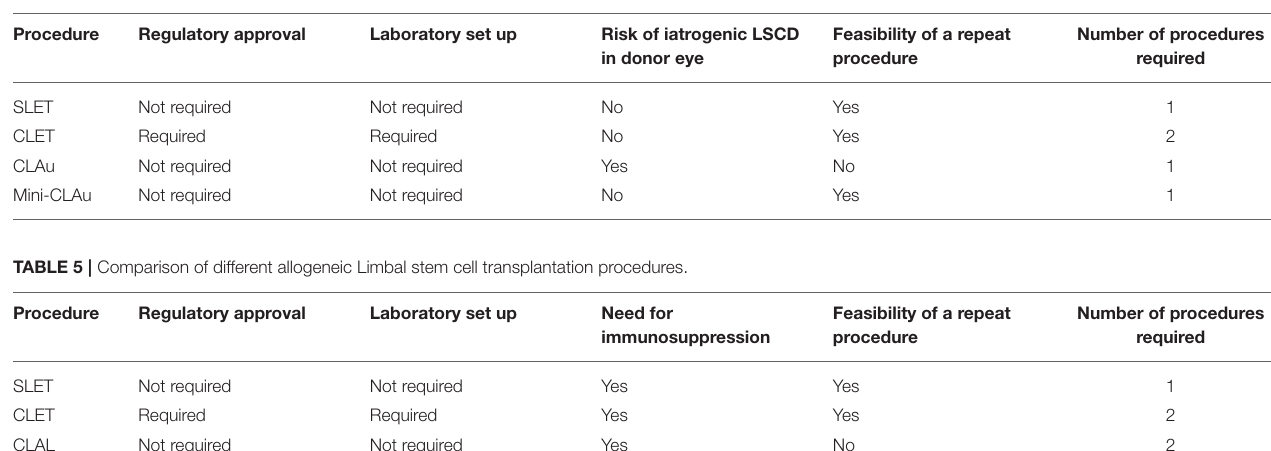
TABLE 4 | Comparison of different autologous Limbal stem cell transplantation procedures.